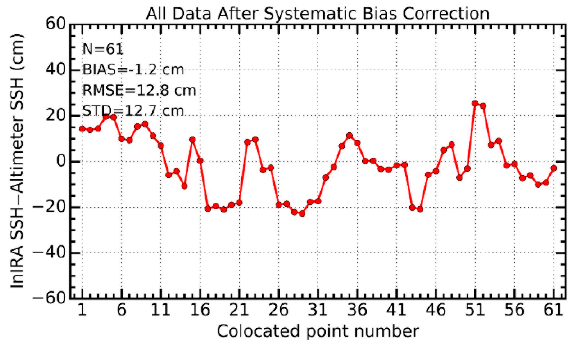
Figure 5. Statistics of the sea surface height (SSH) difference between the Interferometric Imaging Radar Altimeter (InIRA) and all traditional altimeters after systematic bias correction.